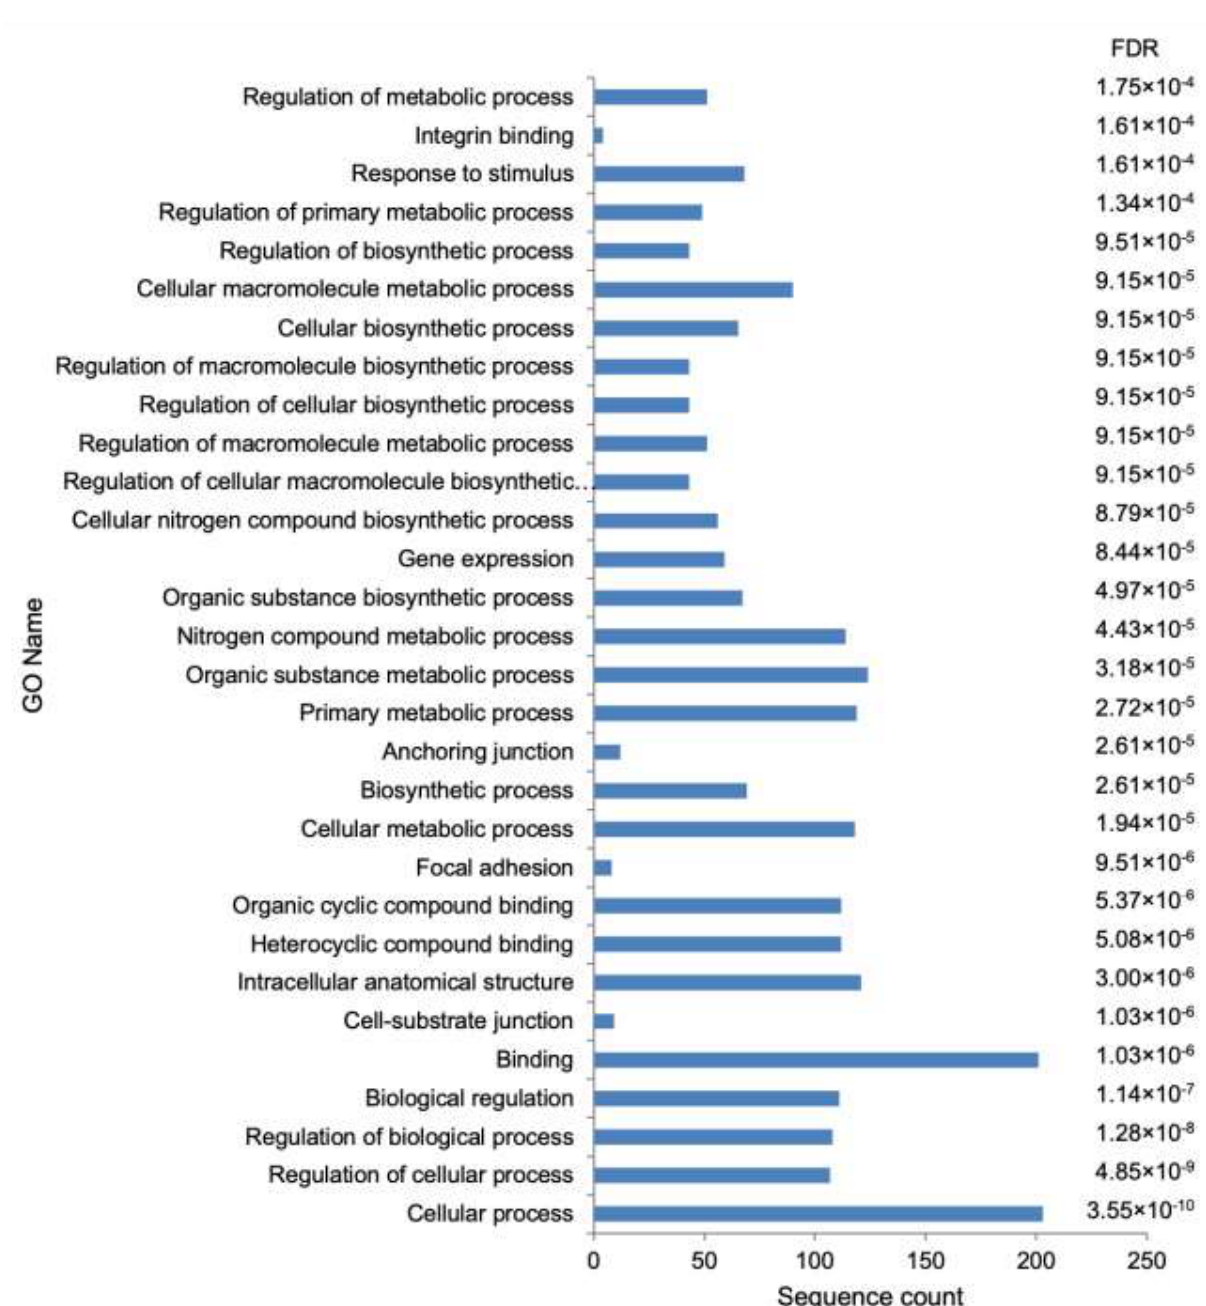
Figure 2. The top 30 most enriched gene ontology (GO) terms of C. rotundicauda differentially expressed genes (DEGs). Sequence count and false discovery rate (FDR) are shown.